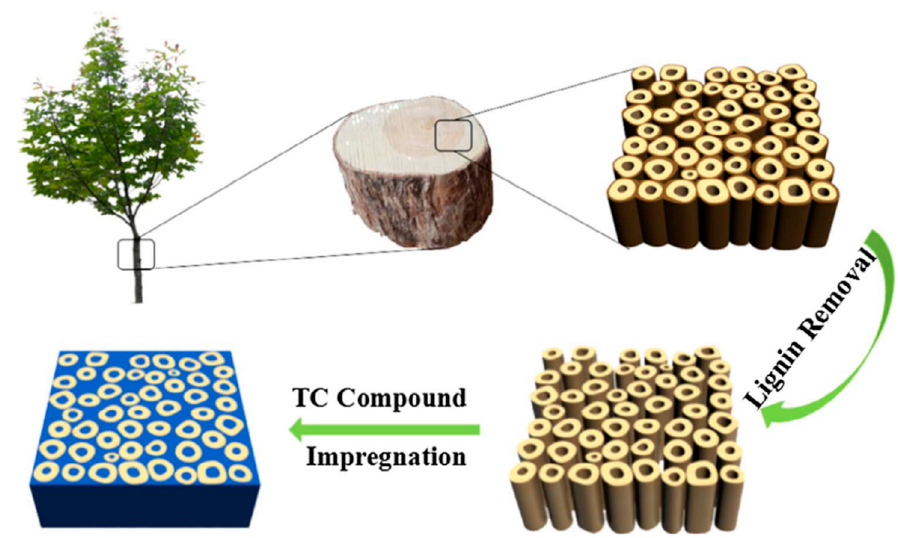
Figure 12. Preparation mechanism of thermochromic wood-based composite PCMs [87].